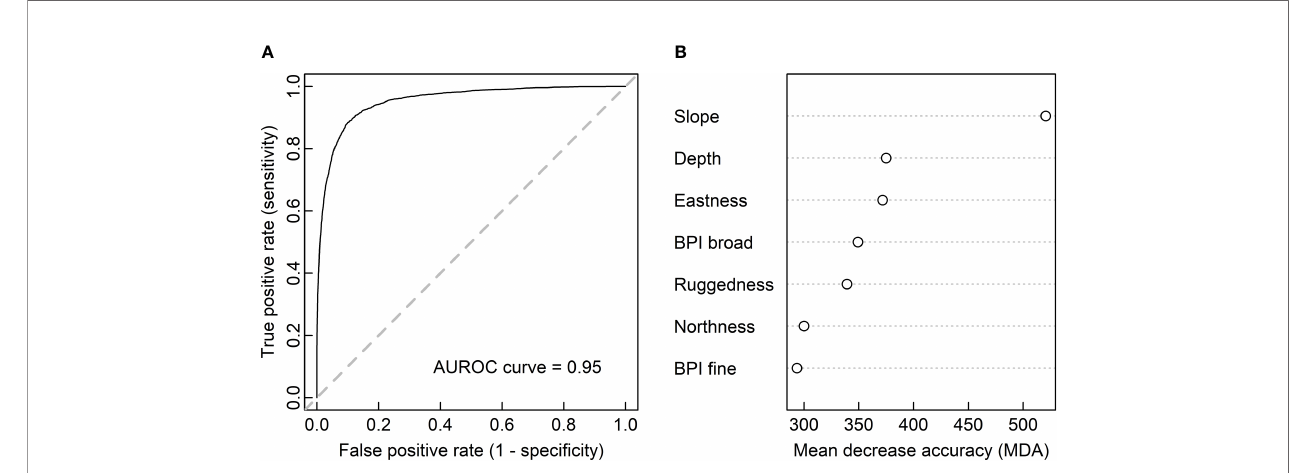
FIGURE 6 | Results of the random forest (RF) coral classi fi cation. Panel (A) shows the prediction model ’ s area under the receiver operating characteristic (AUROC) curve for the test set. The dashed diagonal line symbolizes a hypothetical AUROC curve value of 0.5 (no ability to discriminate between coral and control samples).